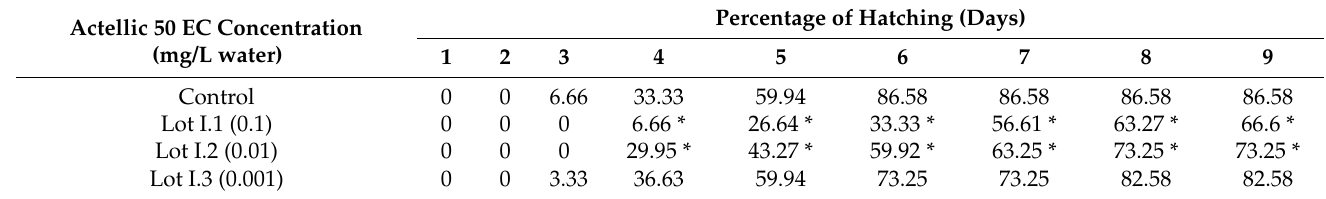
Table 8. The influence of Actellic 50 EC insecticide in different concentrations on the percentage of hatching success.